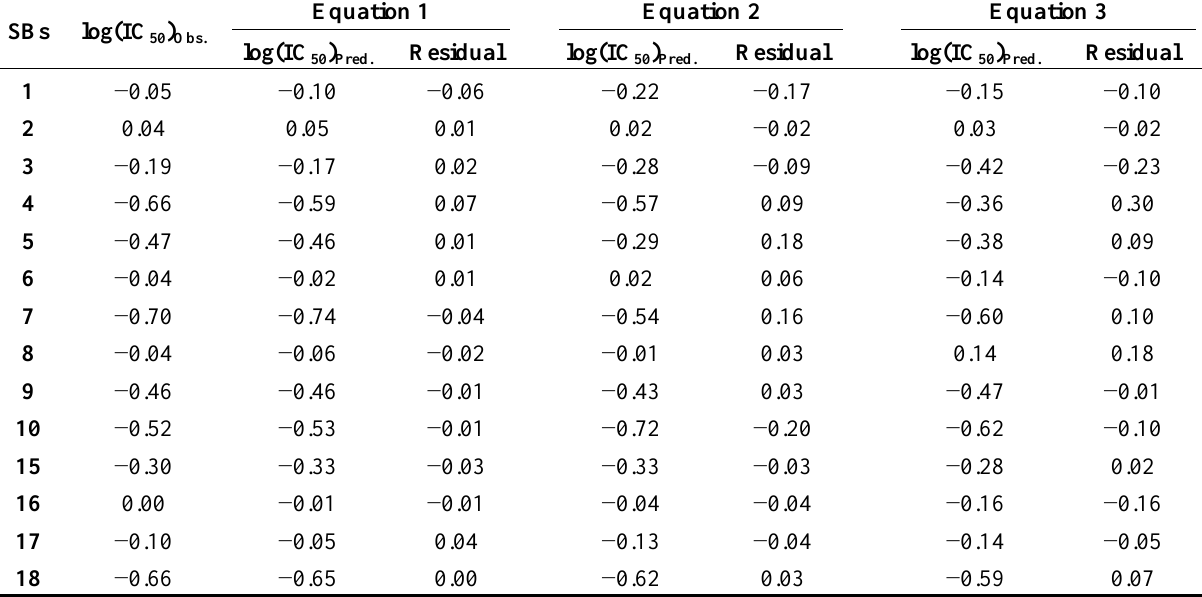
) for the active Schiff bases (SBs). 50